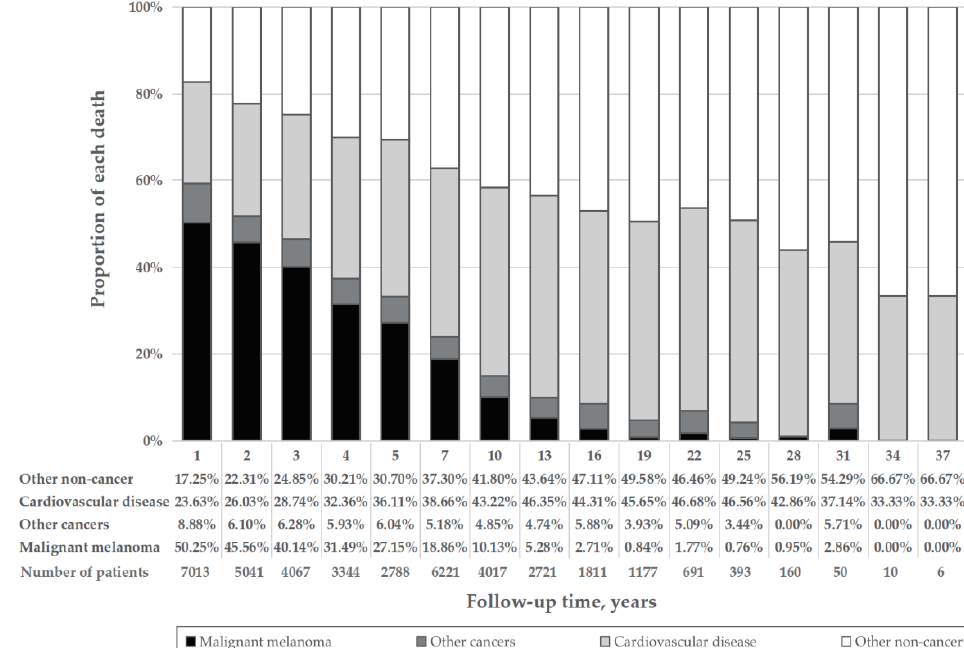
Figure 2. Percentage of each cause of death by follow-up time. The height of the four differently colored stacked bar charts shows the different proportions of deaths from malignant melanoma (black), other cancer death (dark gray), cardiovascular disease (light gray) and other noncancer death (white), respectively. “Years” refers to the middle of the year ra nge of each bar.